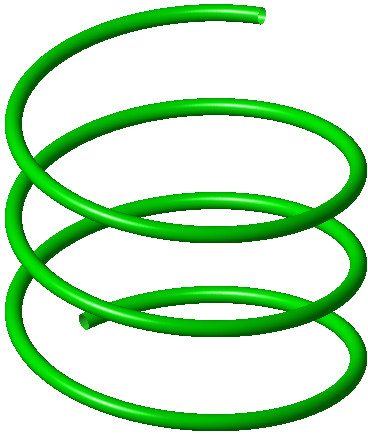
Sketch of a helix.